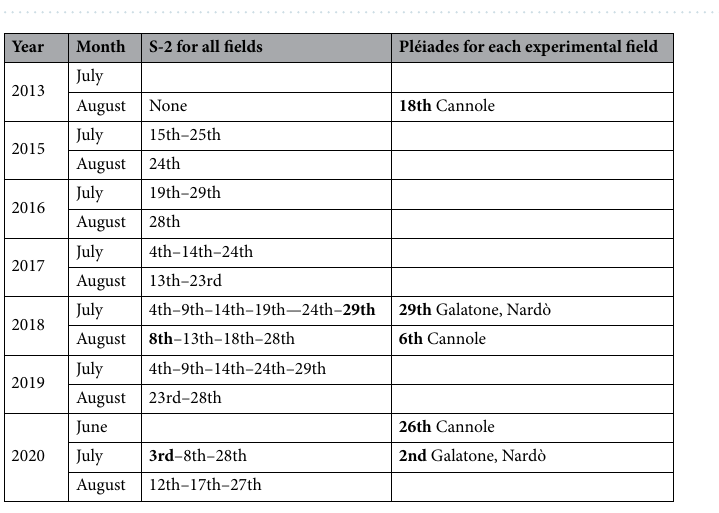
Table 2. Acquisition dates for the inter-annual S-2 time series analysed. Available closest acquisition dates of both S-2 and Pleiades images are evidenced in bold.